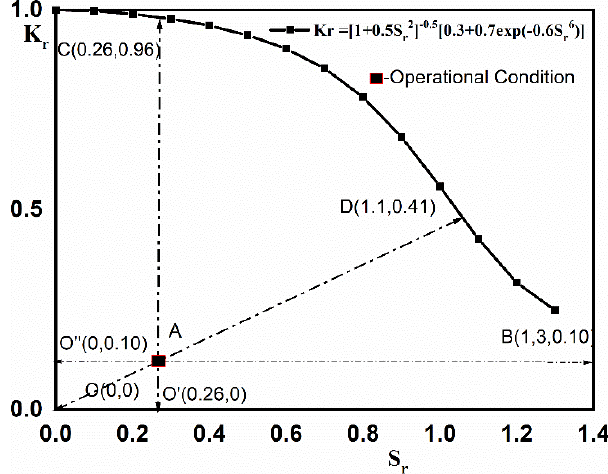
Figure 7. Failure assessment diagram to establish the operational condition.